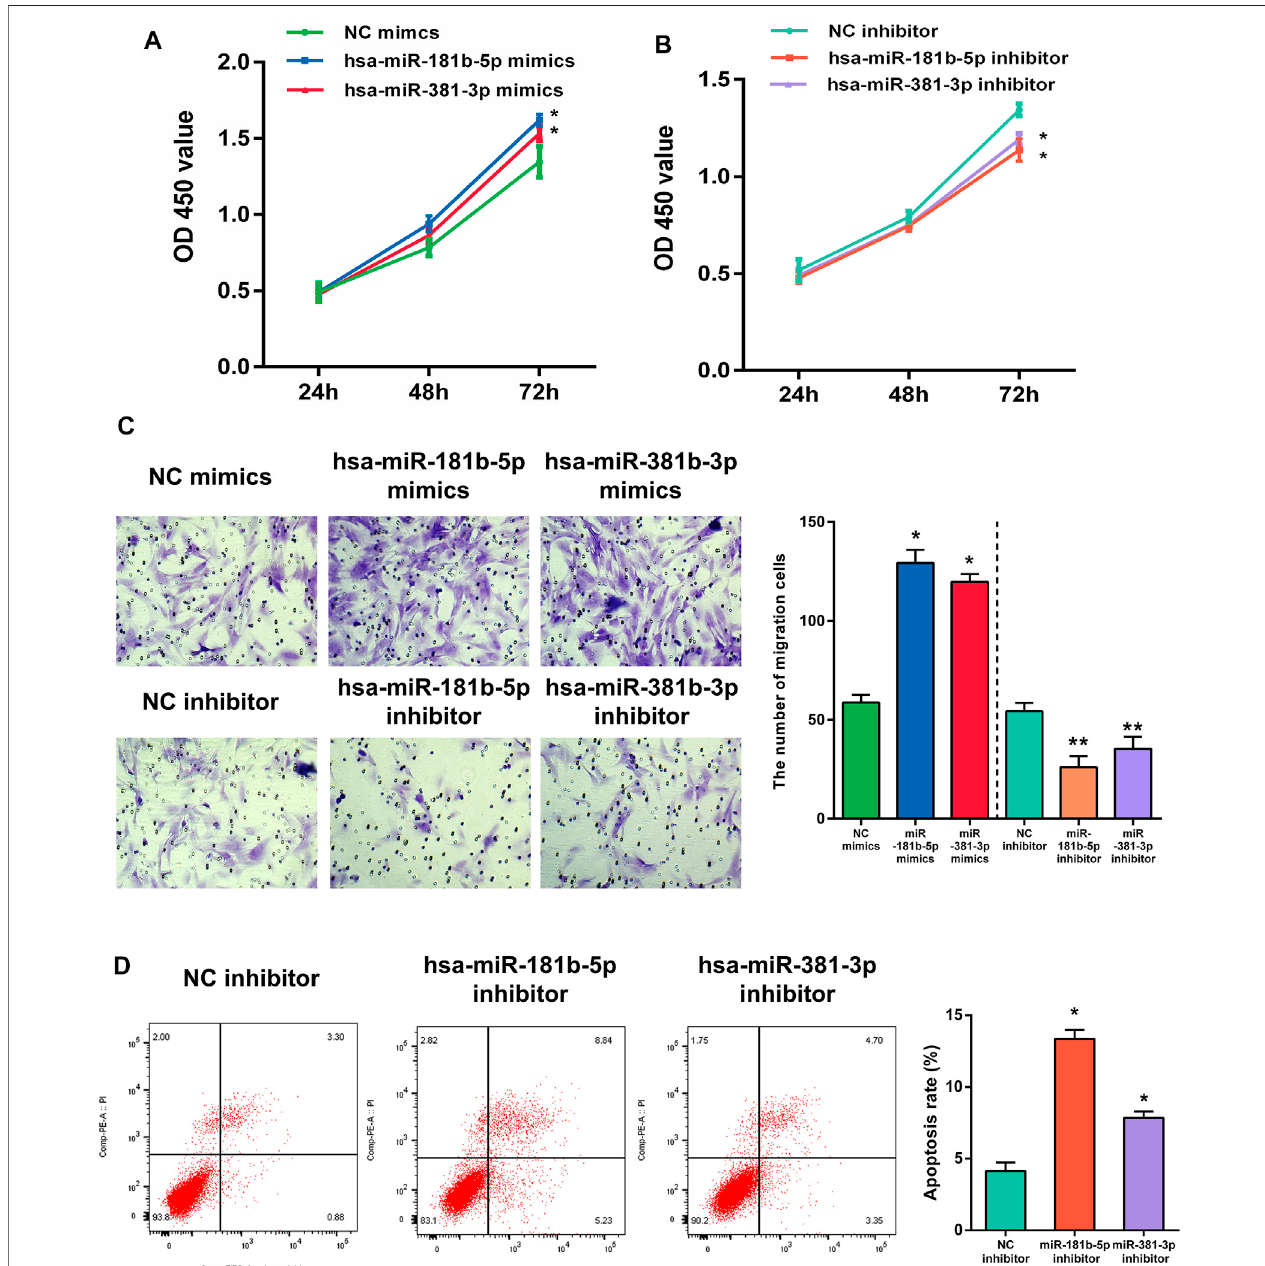
FIGURE 11 | The proliferation of UF cells regulated by (A) overexpression or (B) slience of hub DEMs was detected by CCK-8 assay. (C) The migrational ability of UF cells regulated by overexpression or slience of hub DEMs was detected by Transwell. (D) The apoptosis rates of UF cells regulated by overexpression or slience of hub DEMs was detected by AV/PI